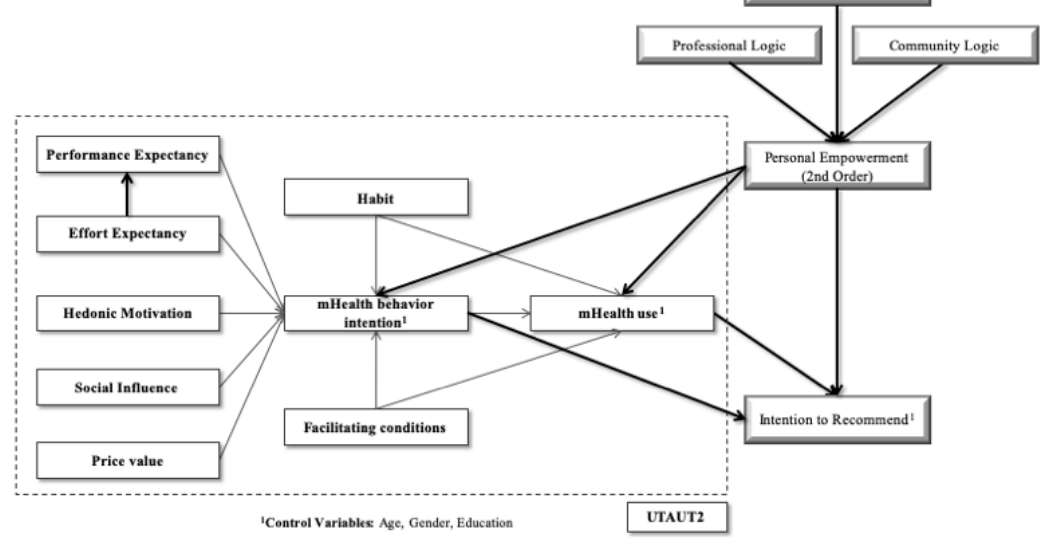
Figure 1. Research model. Original relationships from unified theory of acceptance and usage of technology (UTAUT2) are in black; new relationships from the extended model are in